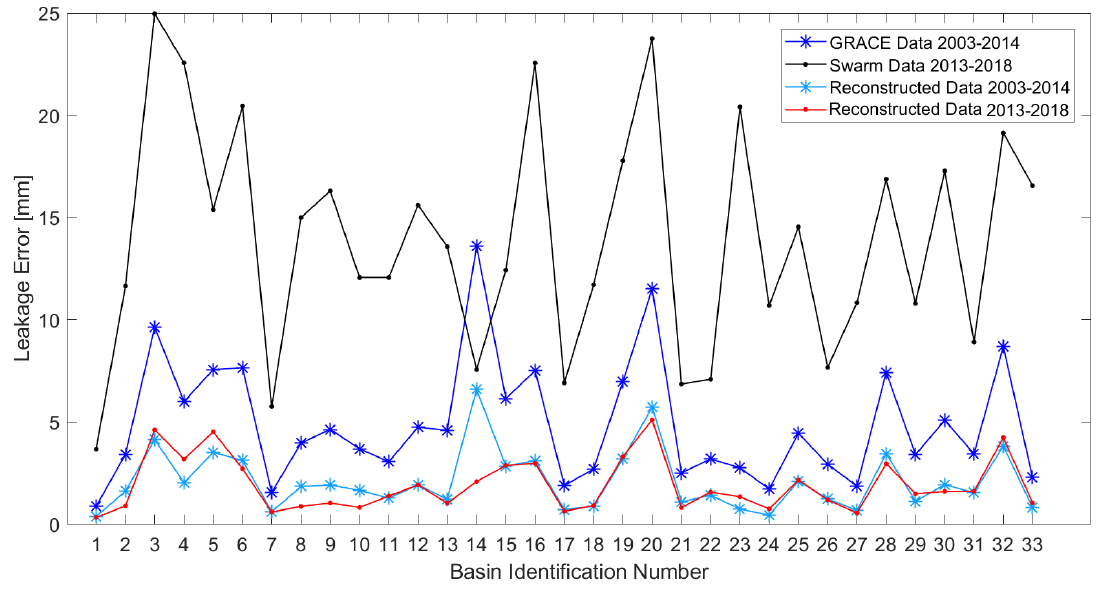
Figure A5. An overview of the standard deviation of the estimated leakage error for the world’s 33 river